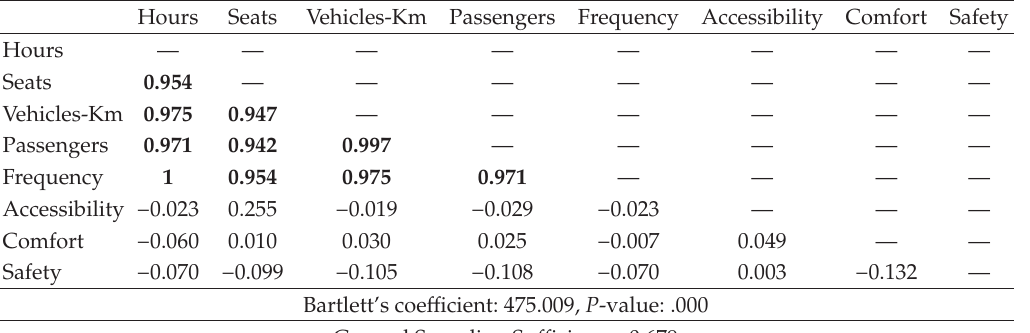
Table 2: Output correlation